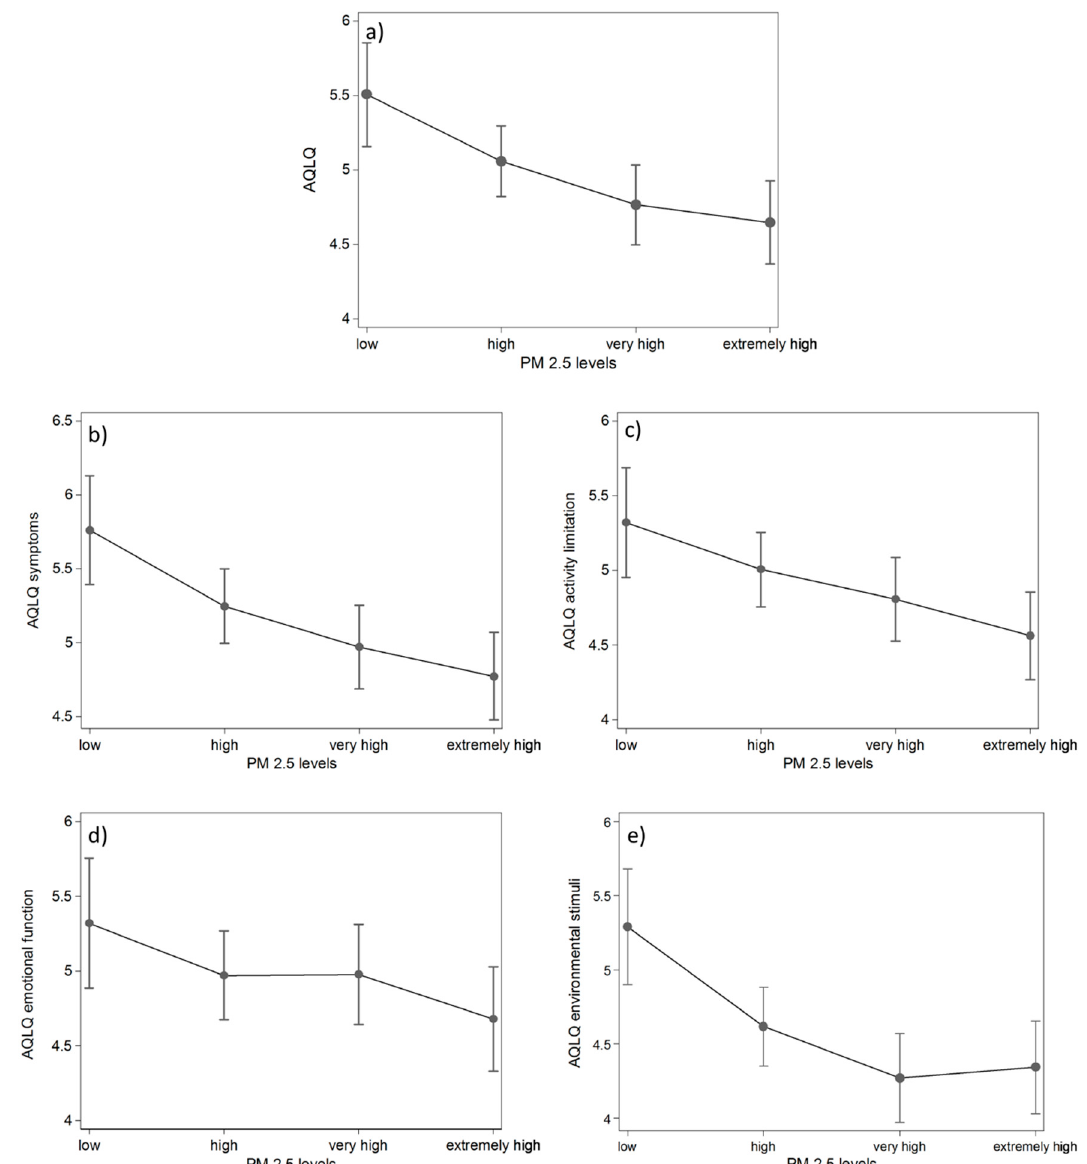
Figure 1. Margins with 95% confidence intervals of ( a ) the Asthma Quality of Life Questionnaire (AQLQ) total, ( b ) AQLQ symptoms, ( c ) activity limitations, ( d ) emotional functioning, and ( e ) environmental stimuli and its domains according to PM 2.5 levels (linear prediction adjusted to age, gender, active smoking, university education, and season of measurement).